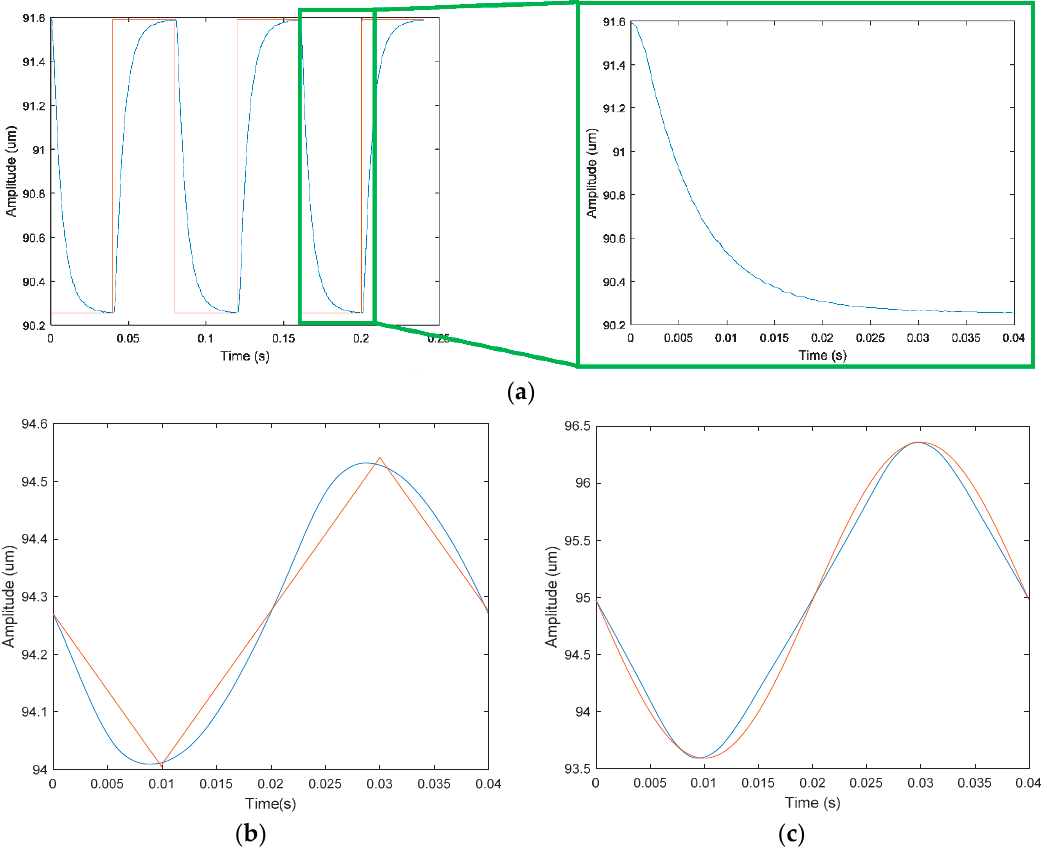
Figure 27. Response curve in x direction. ( a ) Square wave signal; ( b ) triangle wave signal; ( c ) sine wave signal.